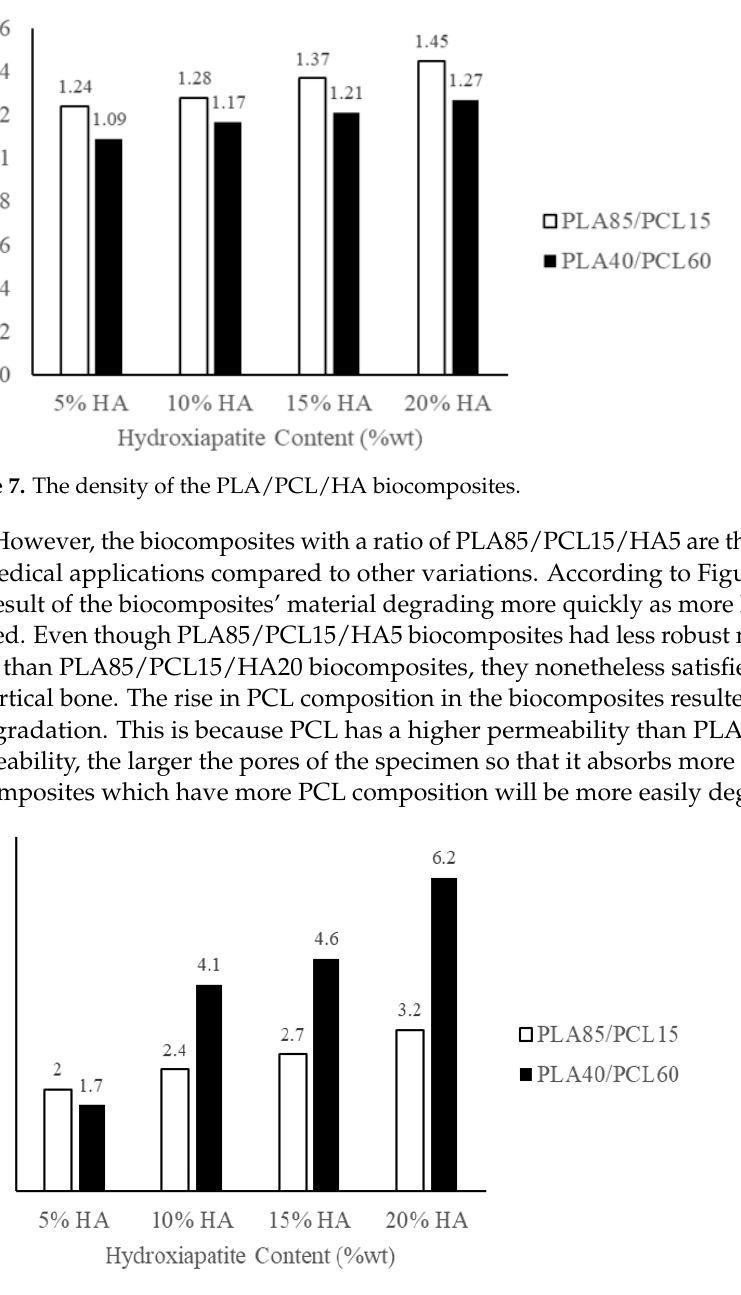
Figure 8. Mass loss of the PLA/PCL/HA biocomposites.